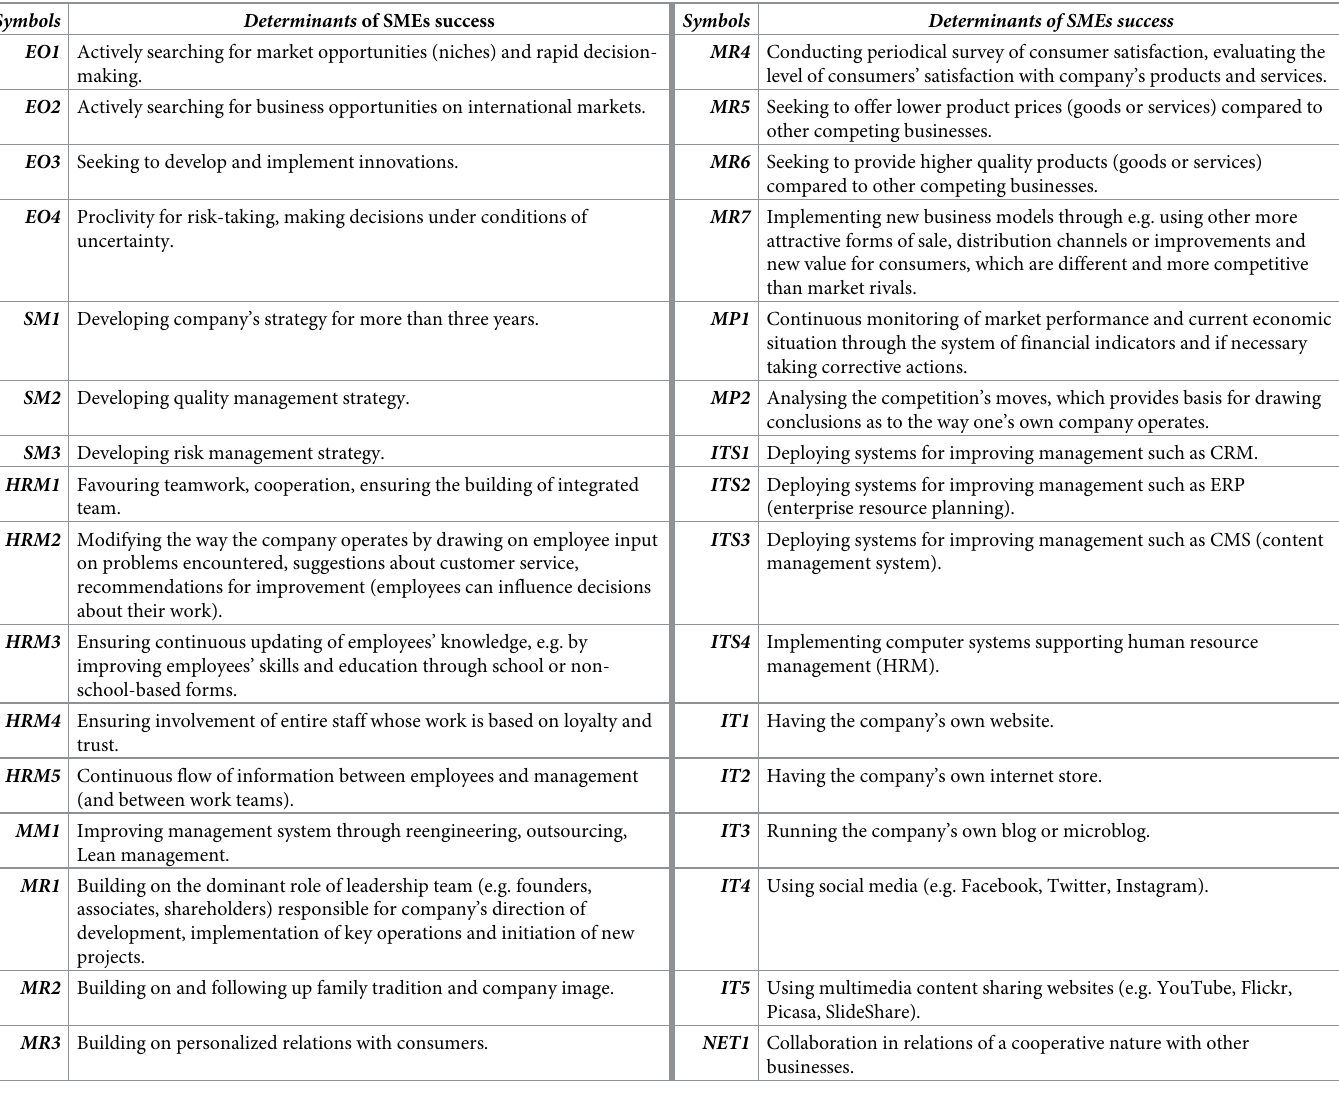
Table 1. SME management practices (as determinants of success).